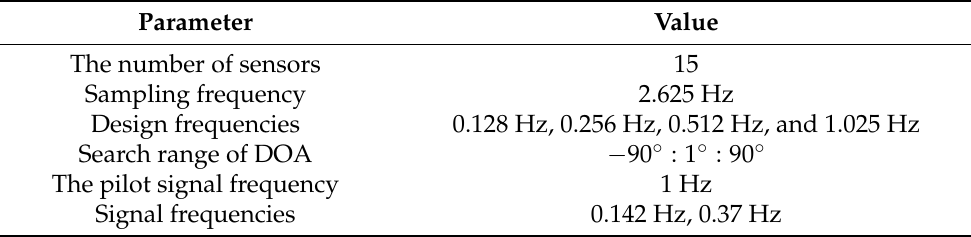
Table 1. Parameters of the measured